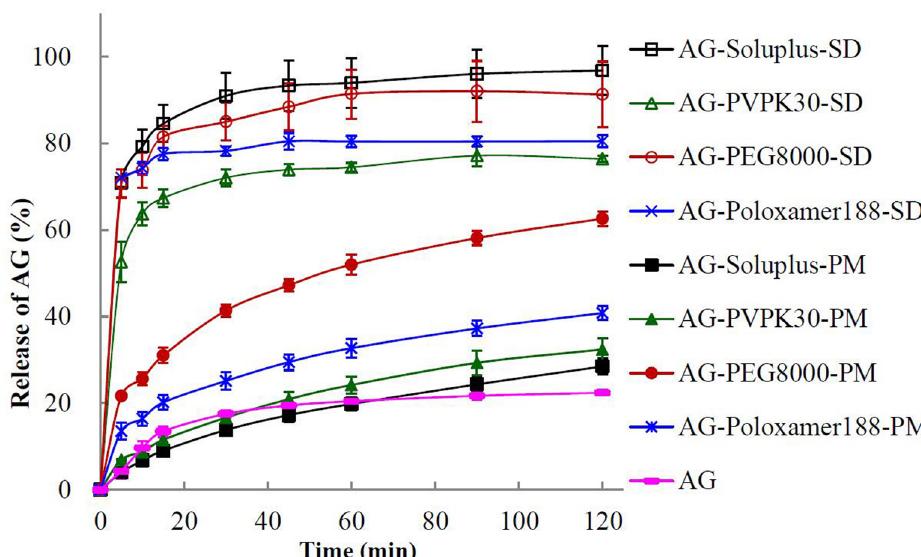
FIGURE 7 - Dissolution profiles of pure andrographolide (AG), physical mixture (PM) and solid dispersion (SD) ( n =